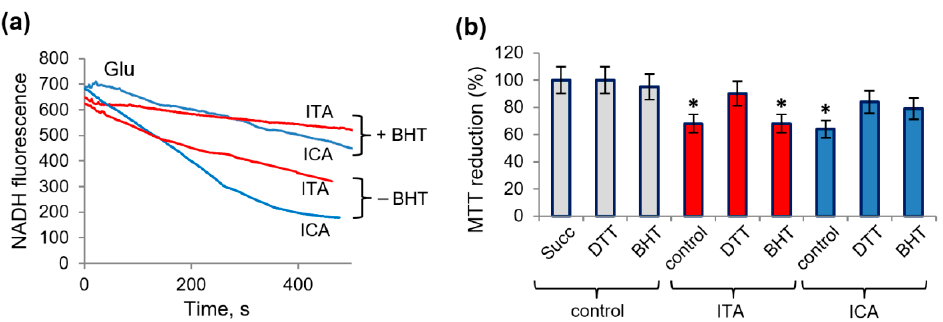
Figure 7. Elimination of the influence of itaconic and indolcaboxylic acids on NADH oxidation and MTT reduction by the antioxidants BHT and DTT. The influence of butyl hydroxytoluene (BHT, 20 μ M) on NADH oxidation induced by ITA and ICA in the presence of glutamate as a substrate ( a ); MTT reduction (%) after the incubation of ITA and ICA with mitochondria in the presence of BHT (20 μ M) or DTT (2 mM) and succinate as a substrate ( b ). Asterisks (*) indicate values that differ significantly from the control values ( p < 0.05).